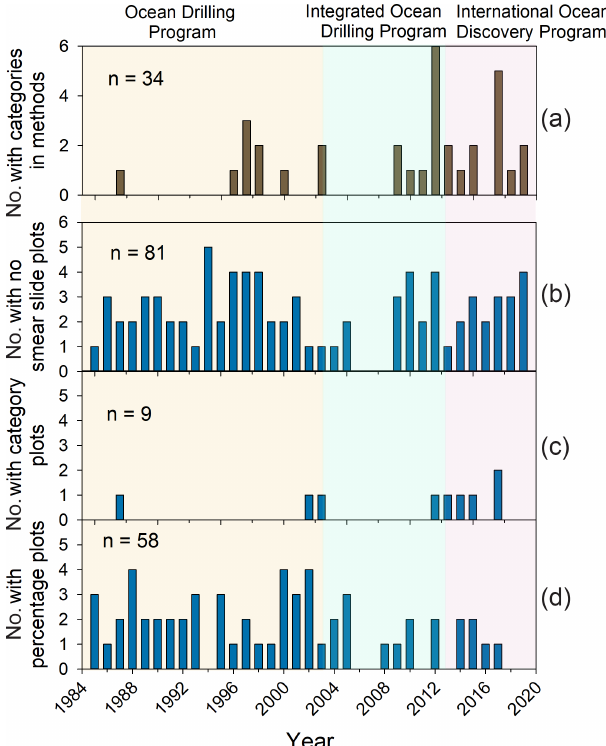
Figure 1. Trends in the presentation of smear slide abundances dur- ing the ODP and IODP phases of scientific ocean drilling between 1985 and 2019. Bars represent the number of expedition reports with each mode of presentation by year. (a) The number of expedi- tion proceedings that included a description in the methods of smear slides being categorized into abundance categories (rare, common, abundant, etc.). (b) The number of expedition reports that did not present smear slide percentages in the report as figures, and these data are only present in the raw data archive. (c) The number of expedition reports that present smear slide data as abundance cate- gories in figures. (d) The number of expedition reports that present smear slide percentages visually as figures (e.g., downcore line or bar